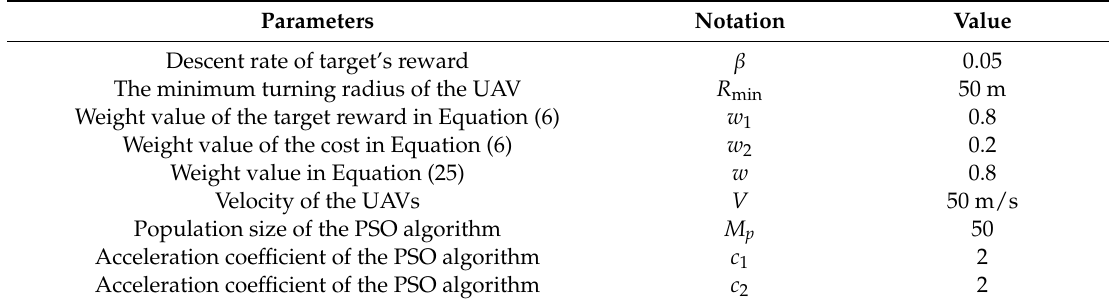
Table 3. Control parameters in the proposed mission planning